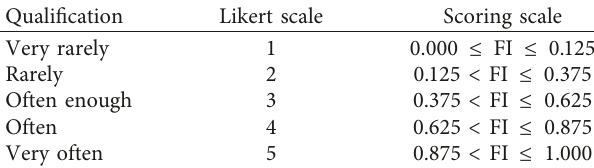
Table 2: Criteria and rating scale FI [30].